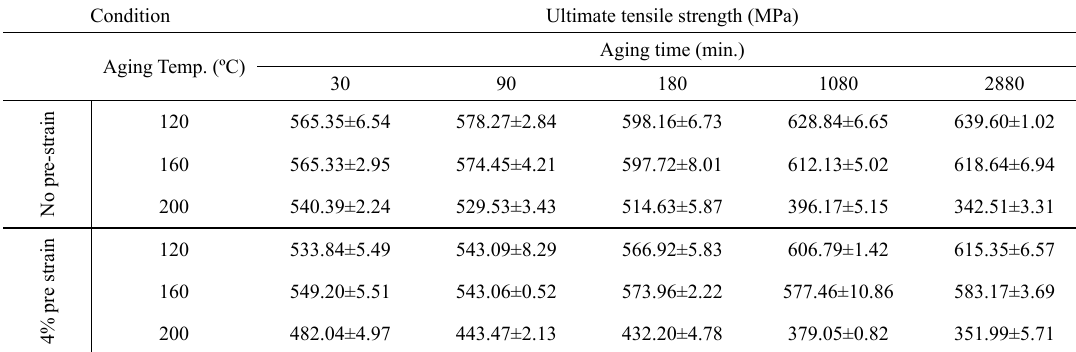
Table 4. Change in tensile